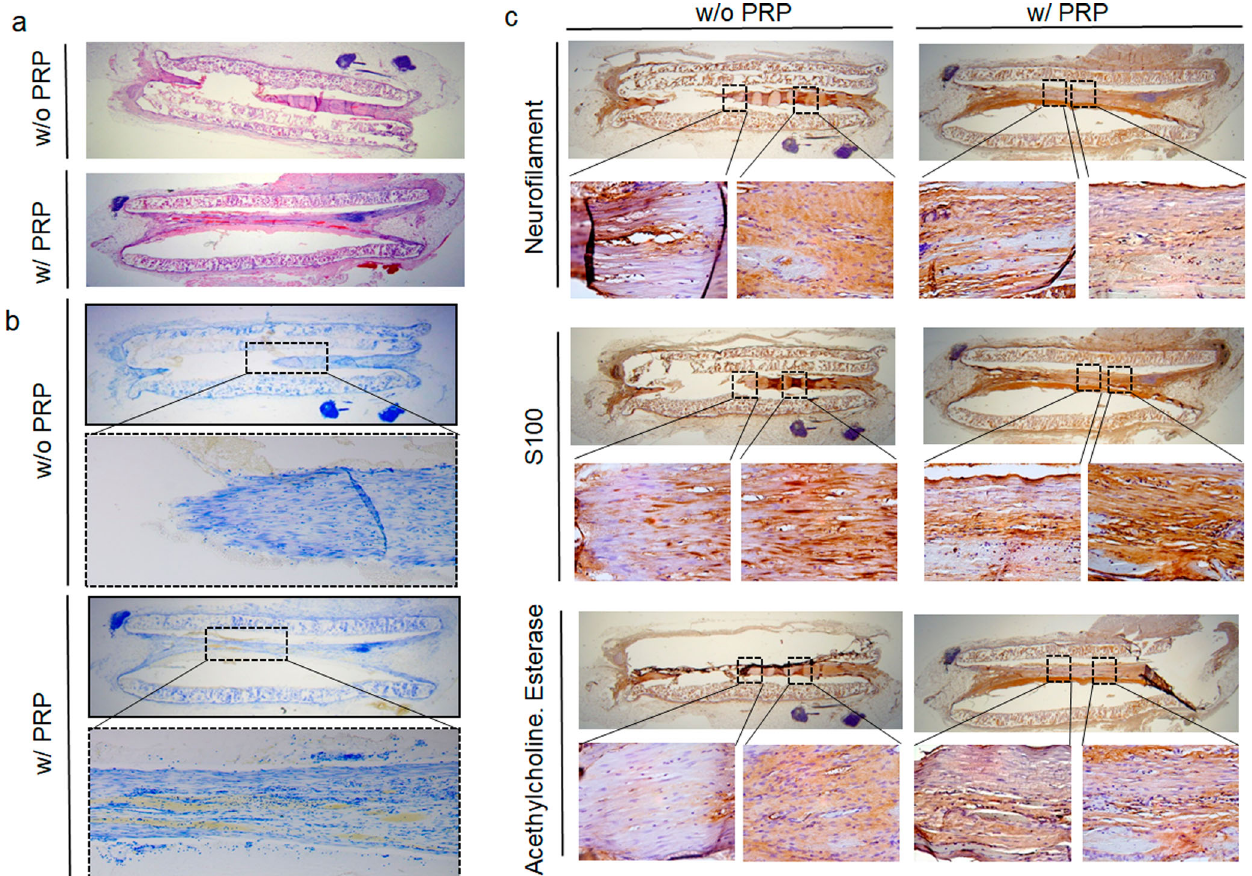
Fig. 7 Histologic evaluation and immunohistochemistry analysis of regenerated RLNs. a, b H&E and toluidine blue staining demonstrated the longitudinal sections along with RLN at 16 weeks post-implantation showing gradual nerve regeneration within NGCs. Nerve budding from each side connected at 16 weeks in the PRP-loaded group. c Immunohistochemistry for NF, S100, and AchE at 16 weeks post- implantation showed strong positivity in the PRP group but not in the non-loaded group. H&E hematoxylin and eosin staining, RLN